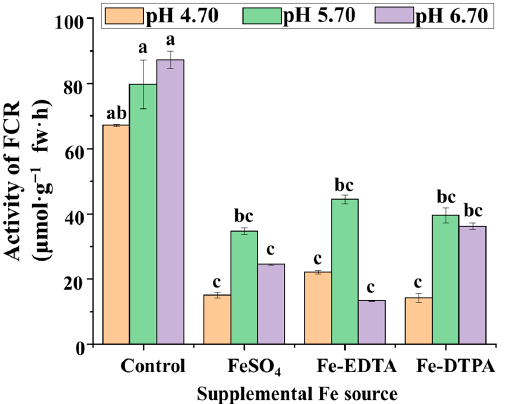
Figure 4. The FCR activities in S. commixta after 6 weeks of culture; fw, fresh weight. Lowercase letters indicate significant differences by the Duncan’s multiple range test at p ≤ 0.05.